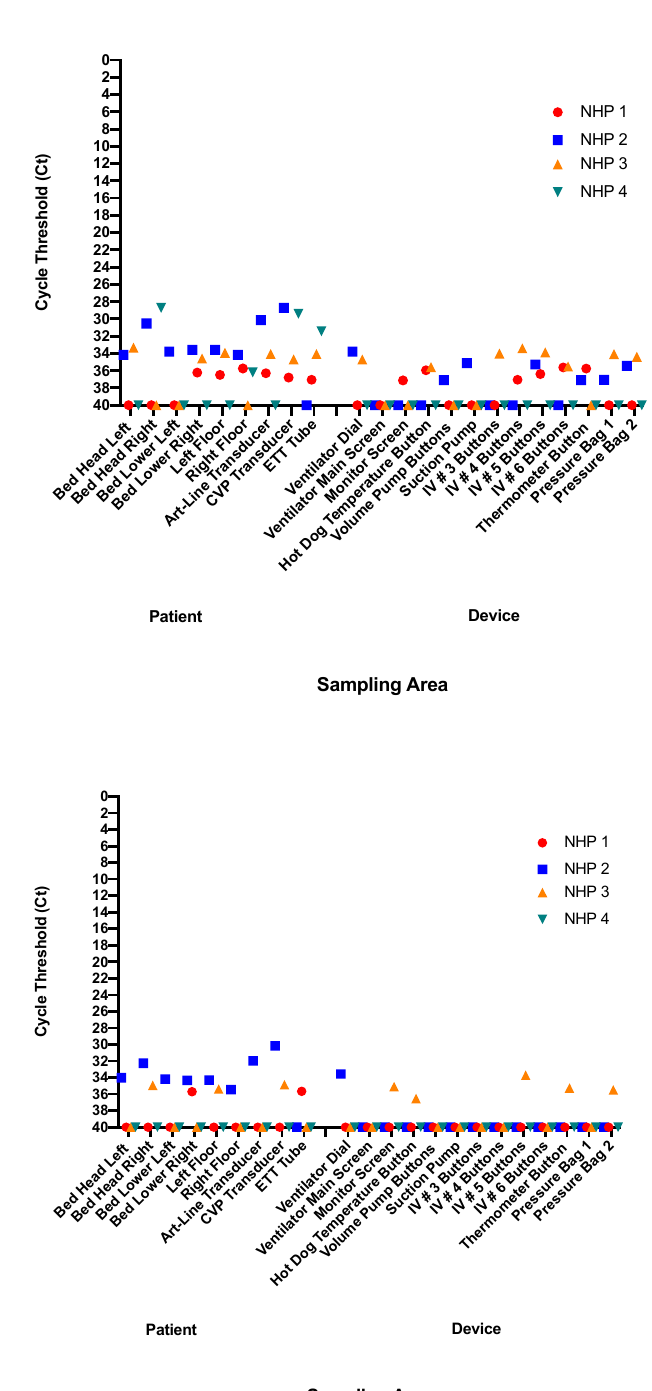
Figure 5. Detection of viral RNA in intensive care unit (ICU) environment at end-point. Following NHP deterioration, environmental surface swabs were collected by swabbing for 5–10 s per surface. Sampling was divided into the patient area including the endotracheal tube (ETT), ART-line and CVP transducers, the right and left sides of the head of the bed, the right and left sides of the bed in line with the NHP, and the floor on either side of the bed. The device area included the Avea Ventilator dial and entirety of screen, the Intellivue MX800 Patient Monitor screen, Alaris SE Volumetric Pump, four Alaris CC Syringe Pumps, the pressure bulbs to maintain adequate pressure for ART-lines, the suction pump, and the HotDog Veterinary Patient Warming System on/off button. All samples were quantified using qPCR for both ( A ) L-gene and ( B ) NP-targets in the patient and device